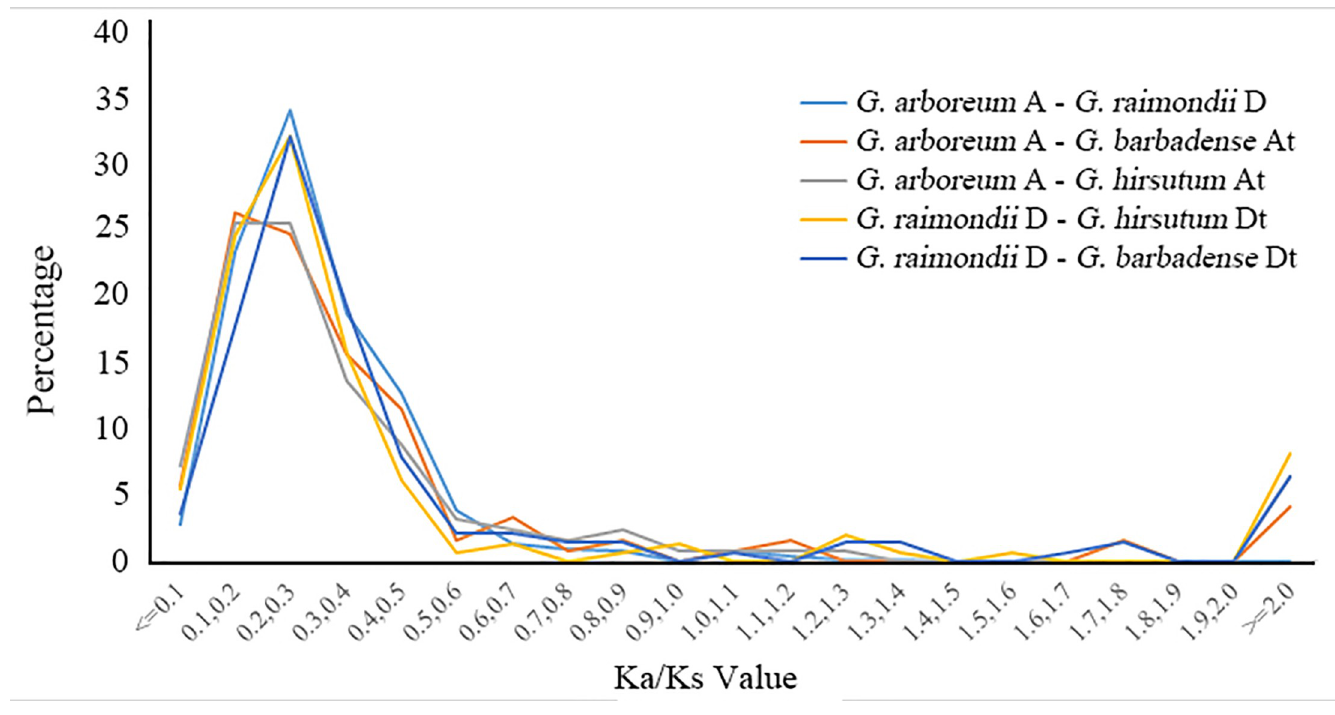
Fig 3. The distribution of